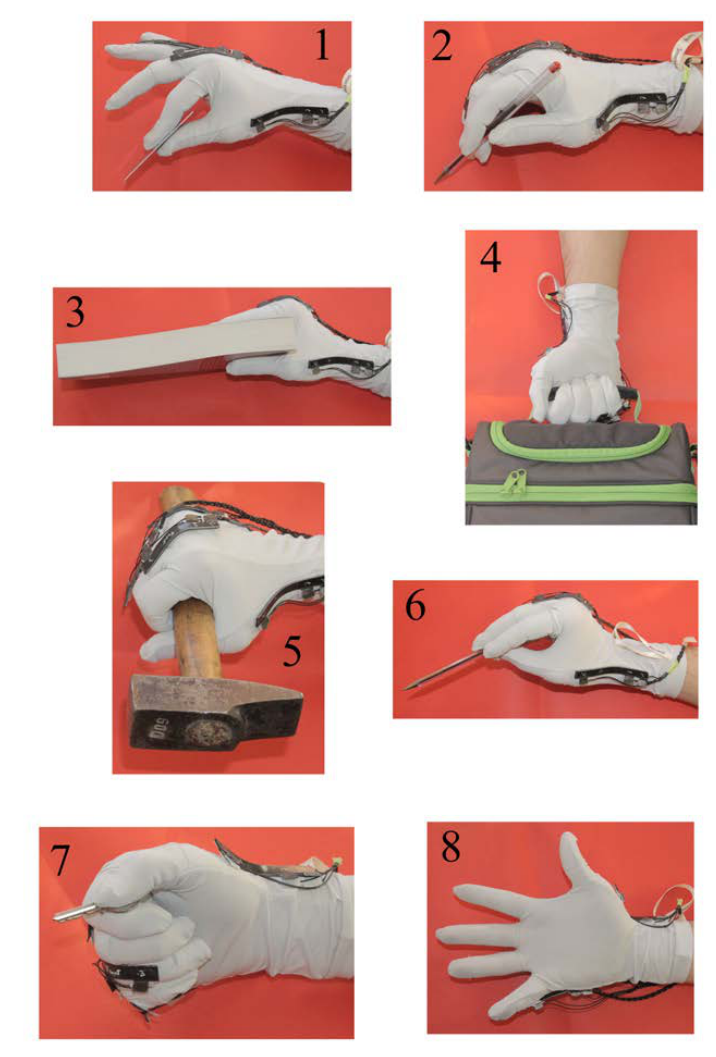
Figure 6. Types of grasp performed during the